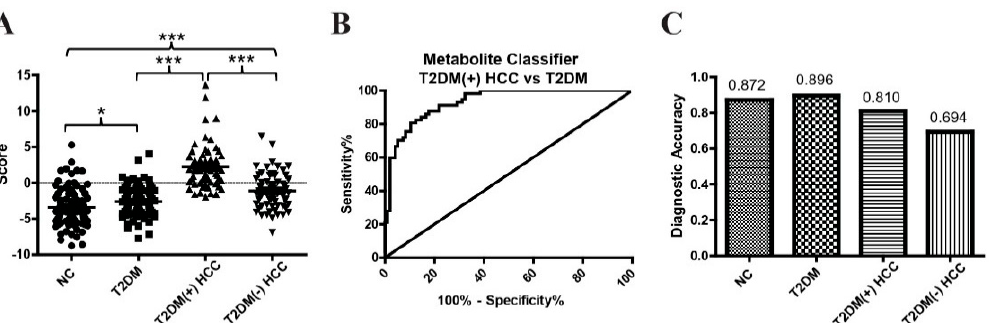
Figure 6. The diagnostic performance of the metabolite classifier in the validation cohort. ( A ) The scores of the metabolite classifier in NC, T2DM, T2DM(+) HCC, and T2DM( − ) HCC individuals in the validation cohort. ( B ) The ROC curve of the metabolite classifier including benzoic acid, creatine, and citrulline for discriminating T2DM(+) HCC patients from T2DM patients. ( C ) The diagnostic accuracy of the metabolite classifier for the diagnosis of NC, T2DM, T2DM(+) HCC, and T2DM( − ) HCC individuals. NC, normal control; T2DM, type 2 diabetes mellitus; HCC, hepatocellular cancer; ROC, receiver operating characteristic. * p value < 0.05; *** p value < 0.001. Table 4. The diagnostic performance of the metabolite classifier for the detection of T2DM(+) HCC.